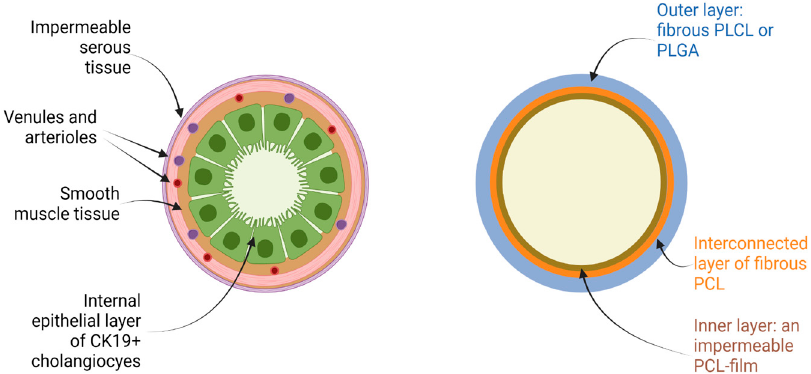
Figure 1. Structure of the native bile duct and multilayered design of the bile duct scaffolds used in the present study. Figure was produced using BioRender platform. the present study. Figure was produced using BioRender